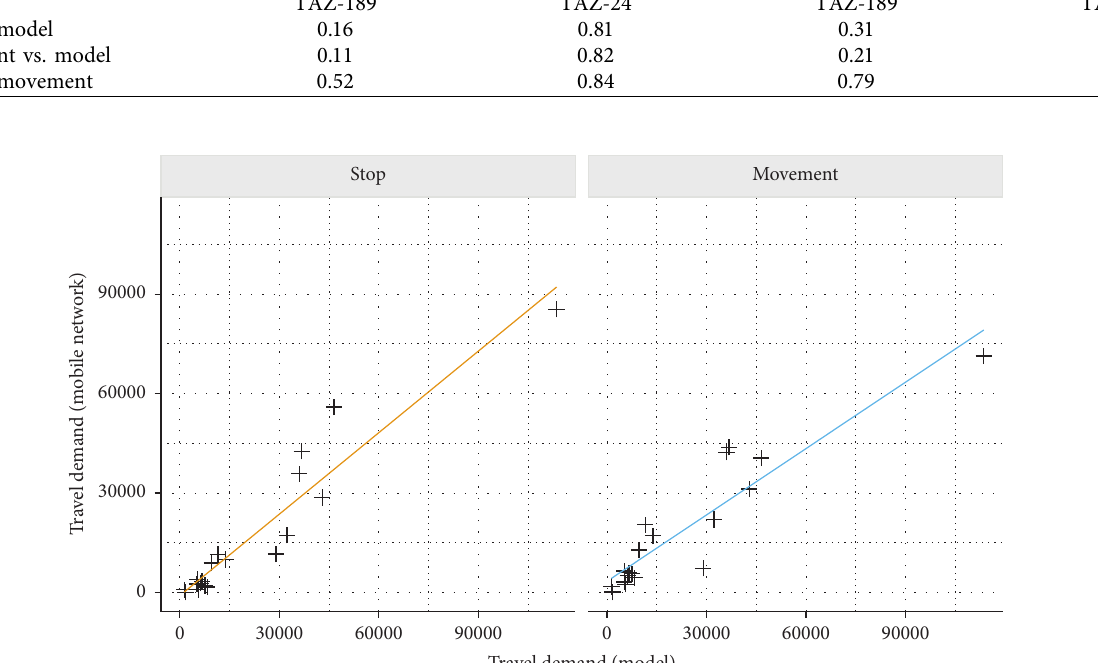
Figure 13: Correlation of the zoneflow (total inflow +outflow) inferred from cellular network data in comparison with the model. Each data point corresponds to an average zoneflow for a TAZ Monday–Thursday (TAZ-24 zoning). The line shows a fitted linear model.